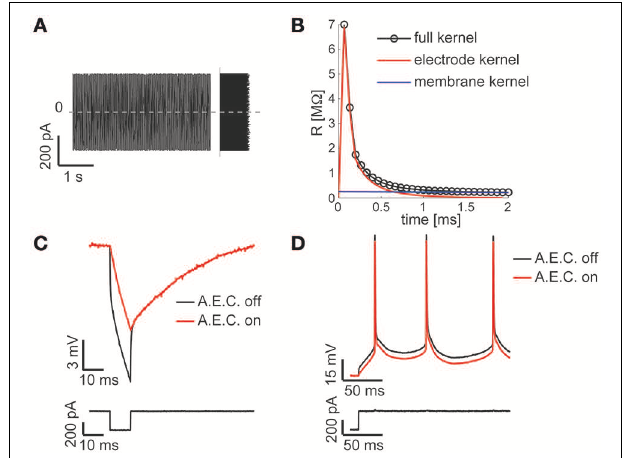
FIGURE 3 | The Active Electrode Compensation (AEC) is built in and available for any application. Our Library is one of the very few software platforms available so far to incorporate the AEC by default (Samu et al., 2012; Linaro et al., 2014 ). Following the method proposed in (Brette et al., 2008), upon intracellular injection of a uniformly distributed fluctuating current (A) , the equivalent transfer properties of the patch-pipette electrode are inferred by the corresponding recorded voltage response (not shown) during each experiment. A linear, non-parametric, dynamical model (i.e., the kernel) is identified and distinguished from the passive membrane response components (B) . When the AEC block is enabled and graphically connected to the output of the DAQ block (as in Figure 2D ), it performs seamless digital subtraction of the instantaneous current injected through the pipette from the recorded voltage, after convolving the current with the estimated electrode kernel. The impact of AEC on subthreshold (C) and suprathreshold responses (D) of the membrane potential of a neuron is then reminiscent, yet more accurate, of the compensation of pipette resistance and pipette capacitance neutralization, usually performed in hardware by the patch-clamp